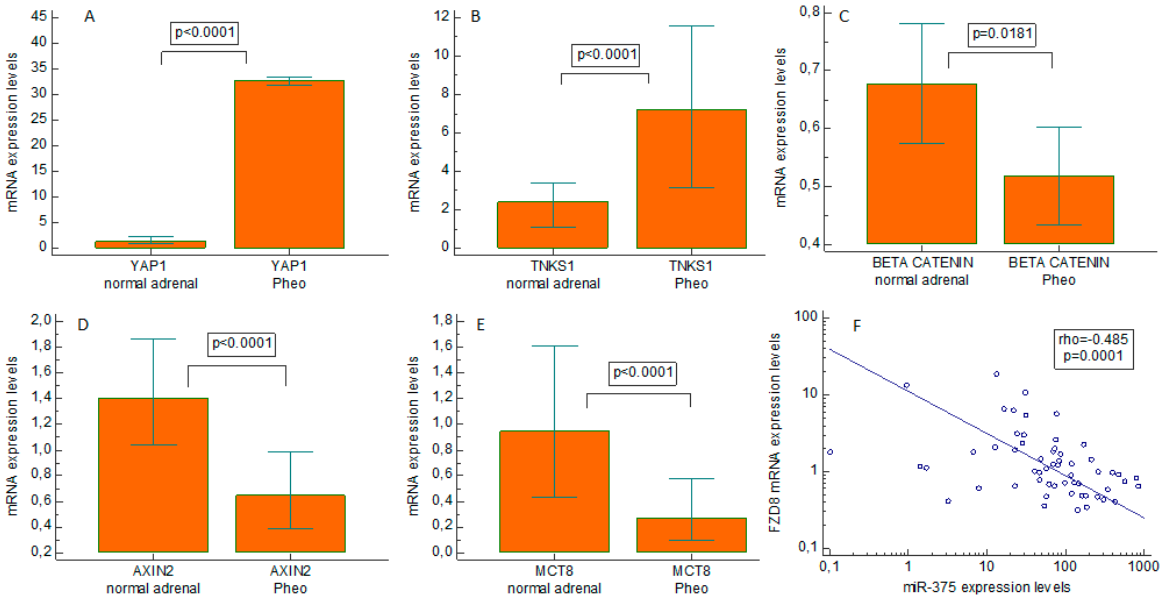
Figure 5. Expression of Hippo and Wingless/Integrated pathways effectors in pheochromocytoma tissues. Real-time quantitative PCR gene expression of Yes-associated protein 1 (YAP1), tankyrase 1 (TNKS1), beta-catenin, axin2, and monocarboxylate transporter 8 (MCT8) in pheochromocytoma specimens and paired normal tissues. ( A ) YAP1; ( B ) TNKS1; ( C ) beta-catenin; ( D ) axin2; and ( E ) MCT8. Negative correlation between Frizzled 8 (FZD8) and the miR-375 expression level ( F ). Pheo: